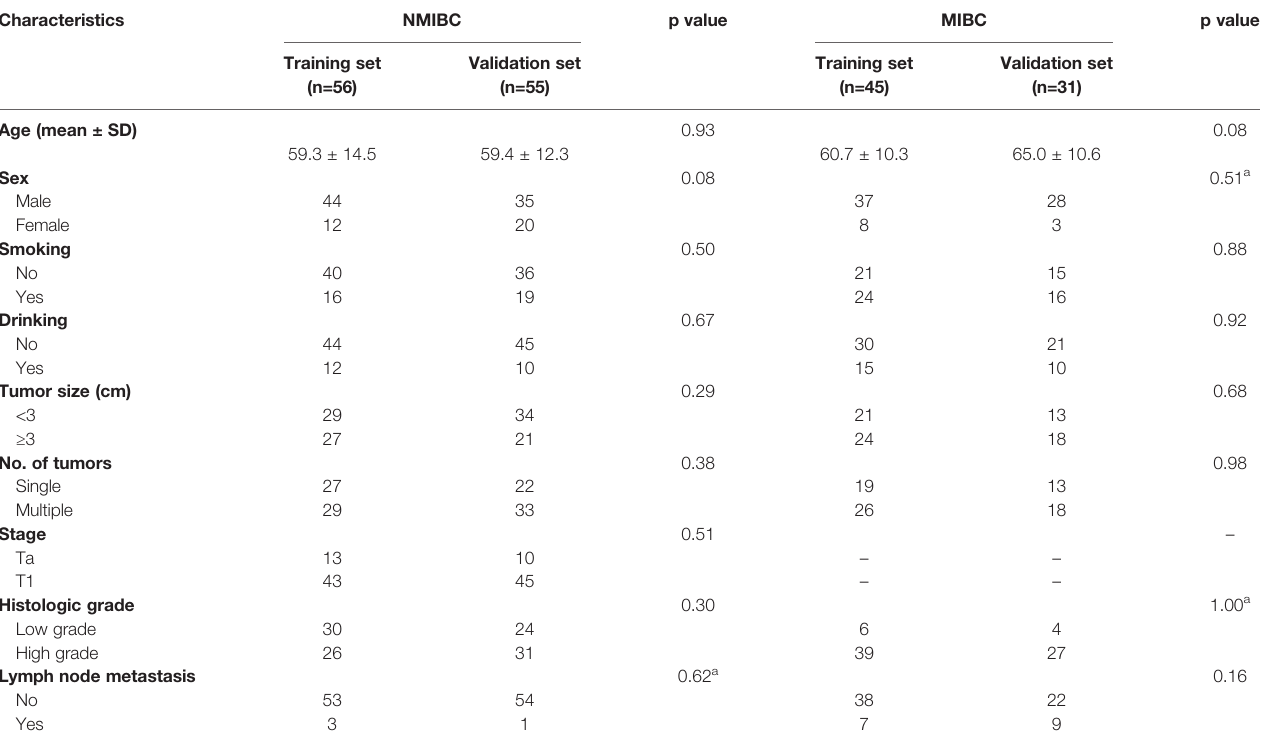
TABLE 6 | Clinicopathological characteristics of BC patients in the prediction model.